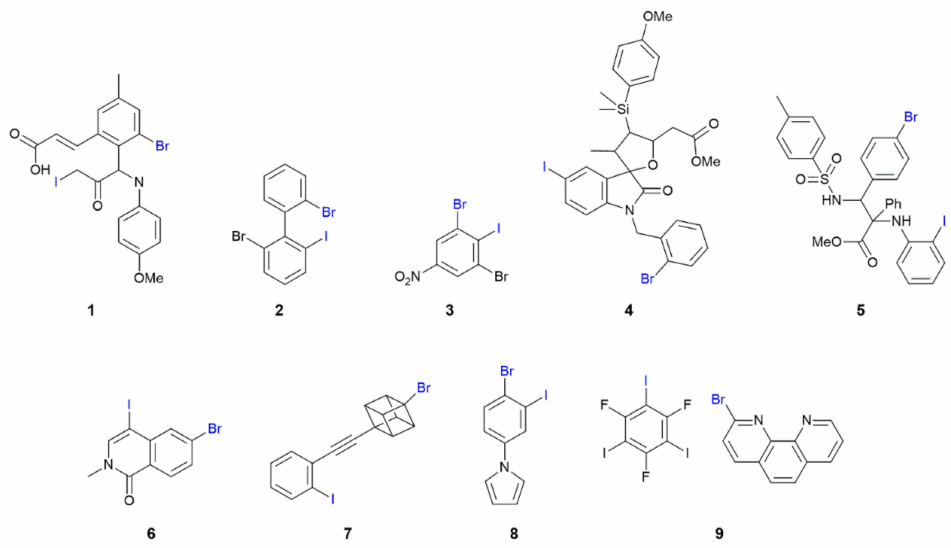
Figure 3. Chemical diagrams for molecules that form I · · · Br interactions in their crystals leading to zero-dimensional aggregation patterns ( 1 – 9 ). The atoms highlighted in blue are the atoms forming the I · · · Br interaction.